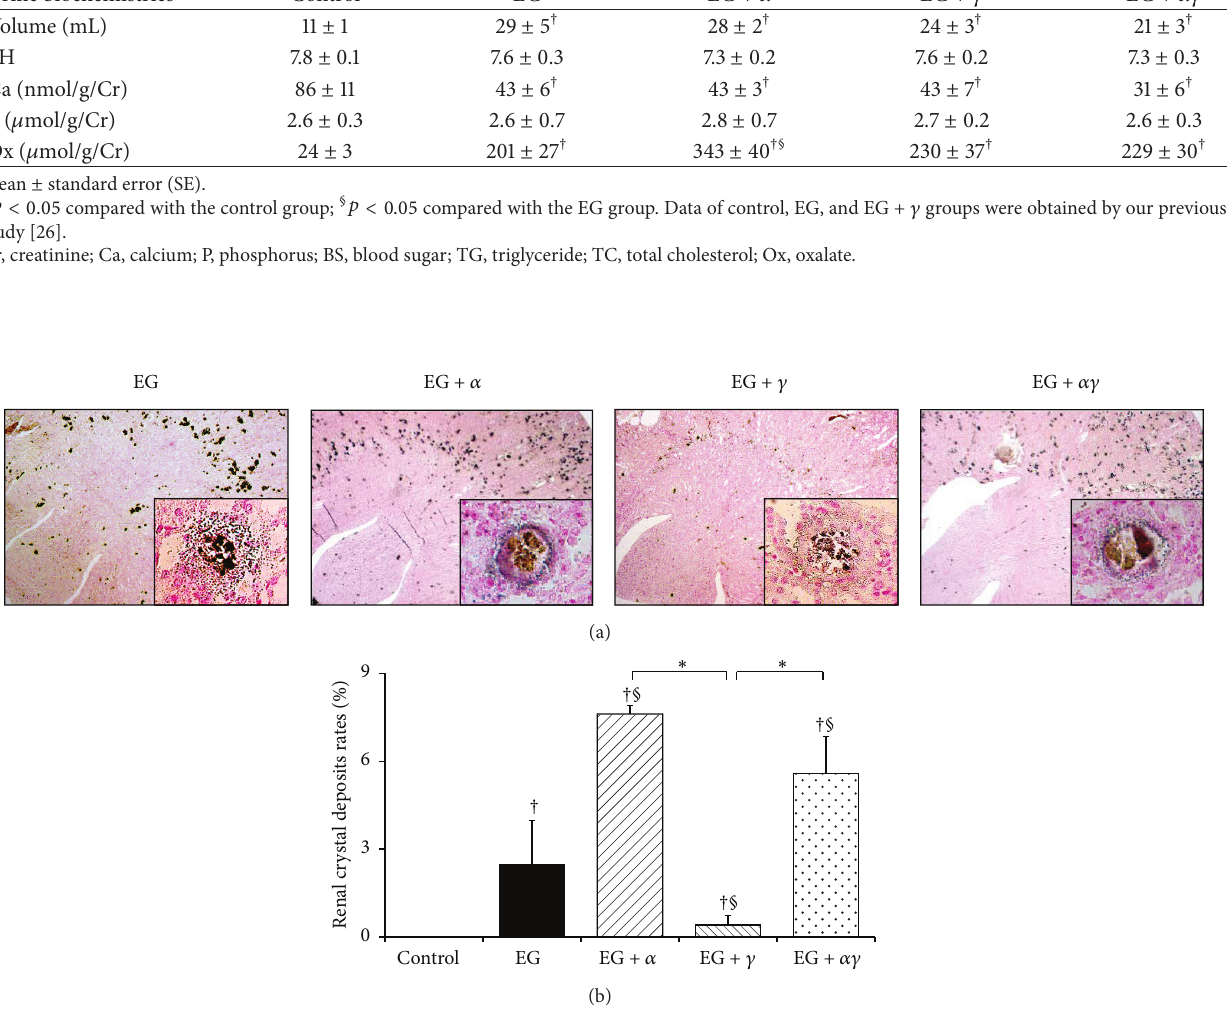
Figure 2: Deposits of renal CaOx crystals in model rats observed using Pizzolato staining and quantitative estimation. (a) Representative micrographs of renal sections obtained on day 14. Magnification: 40x (inset: 400x). (b) Quantitative estimation of renal CaOx crystals. Crystallization in each kidney section was quantified by calculating the ratio (%) of the area with crystals to that of the entire kidney section by using Image Pro Plus ( 𝑛 = 6 for all groups). Data are presented as mean ± SE. ∗ 𝑝 < 0.05 among EG + 𝛼 , EG + 𝛾 , and EG + 𝛼𝛾 groups; † 𝑝 < 0.05 compared with the control group; § 𝑝 < 0.05 compared with the EG group. Data of control, EG, and EG + 𝛾 groups obtained by our previous study